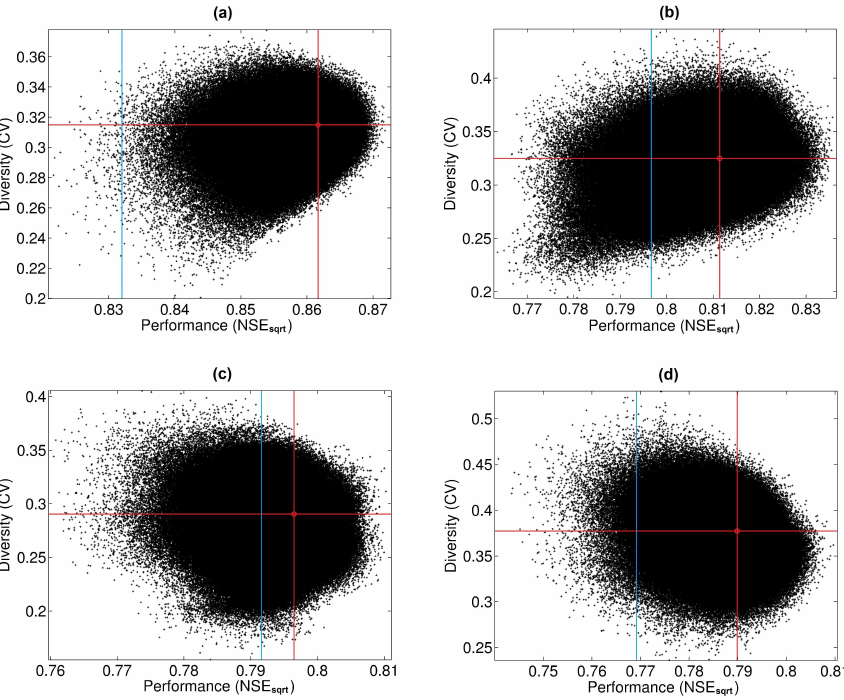
Fig. 11. Validation performance (NSE sqrt ) and diversity (CV) for all model combinations (2 20 points) and Differential Split Sample Tests for the Au Saumon catchment (SAU): (a) calibration on DW years (dry/warm) and validation on HC years (humid/cold); (b) calibration on HC years (humid/cold) and validation on DW years (dry/warm); (c) calibration on DC years (dry/cold) and validation on HW years (humid/warm); (d) calibration on HW years (humid/warm) and validation on DC years (dry/cold). Red lines and circle illustrate performance and diversity of the twenty-member ensembles and blue lines, of the best individual model for each